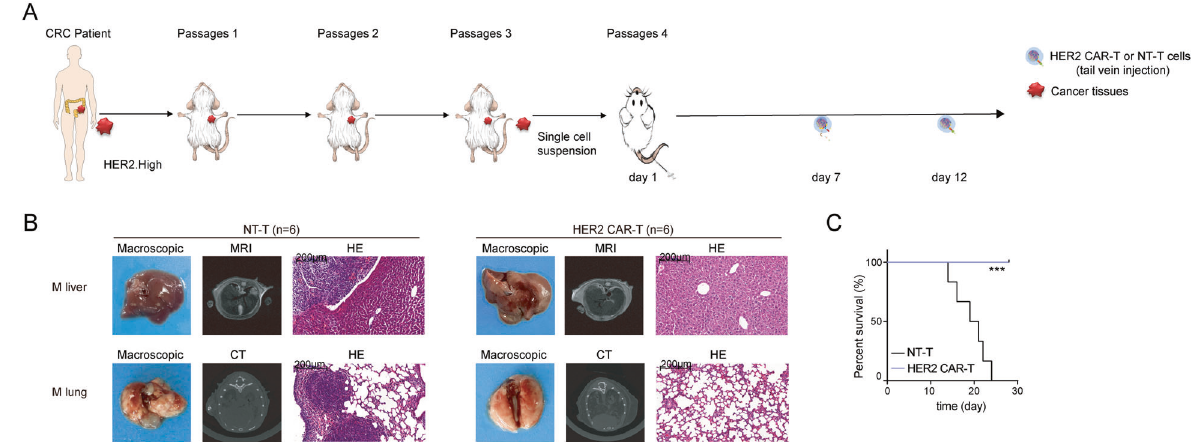
Fig. 6 HER2 CAR-T cells have effective immunotherapeutic capacity for mCRC. A Left panel: Fresh human CRC tissues were transplanted into NCG mice. After three passages, single-cell suspension of the PDX tumor cells (HER2.High: high expression of HER2) was obtained. Right panel: Schematic of the PDX metastasis models ( n = 12). Then, two consecutive injections of T cells (1 × 10 7 ) were administered after single- cell suspension was injected into the NCG mice via a tail vein. B MRI, CT, and H&E were performed to evaluate the pathological changes in the liver and lungs (M liver: liver metastasis, M lung: lung metastasis), and the representative images are shown. The scale bar is marked in each image. C KM analysis of the overall survival of mice. (*** P < 0.001, compared with NT-T, Log-rank test).